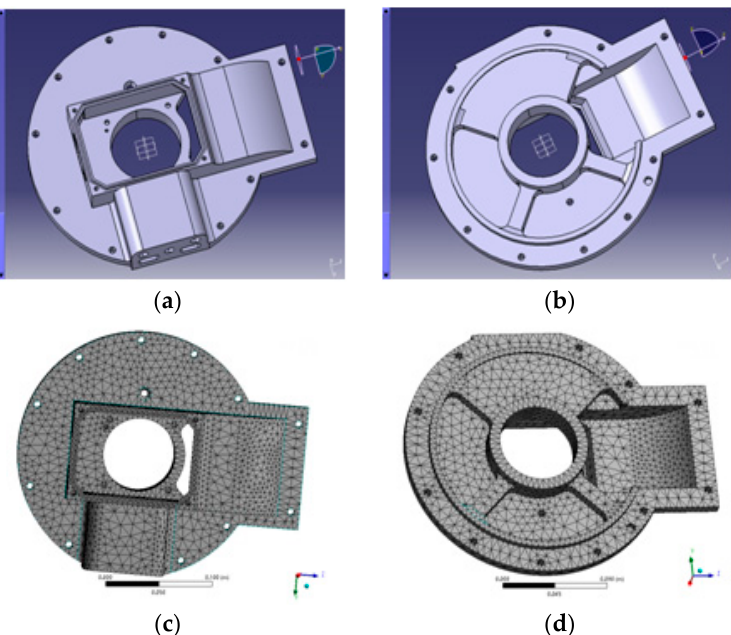
Figure 4. CAD and FEM model of middle product: ( a ) CAD model of side A ( b ) CAD model of side B ( c ) FEM model of side A ( d ) FEM model of side